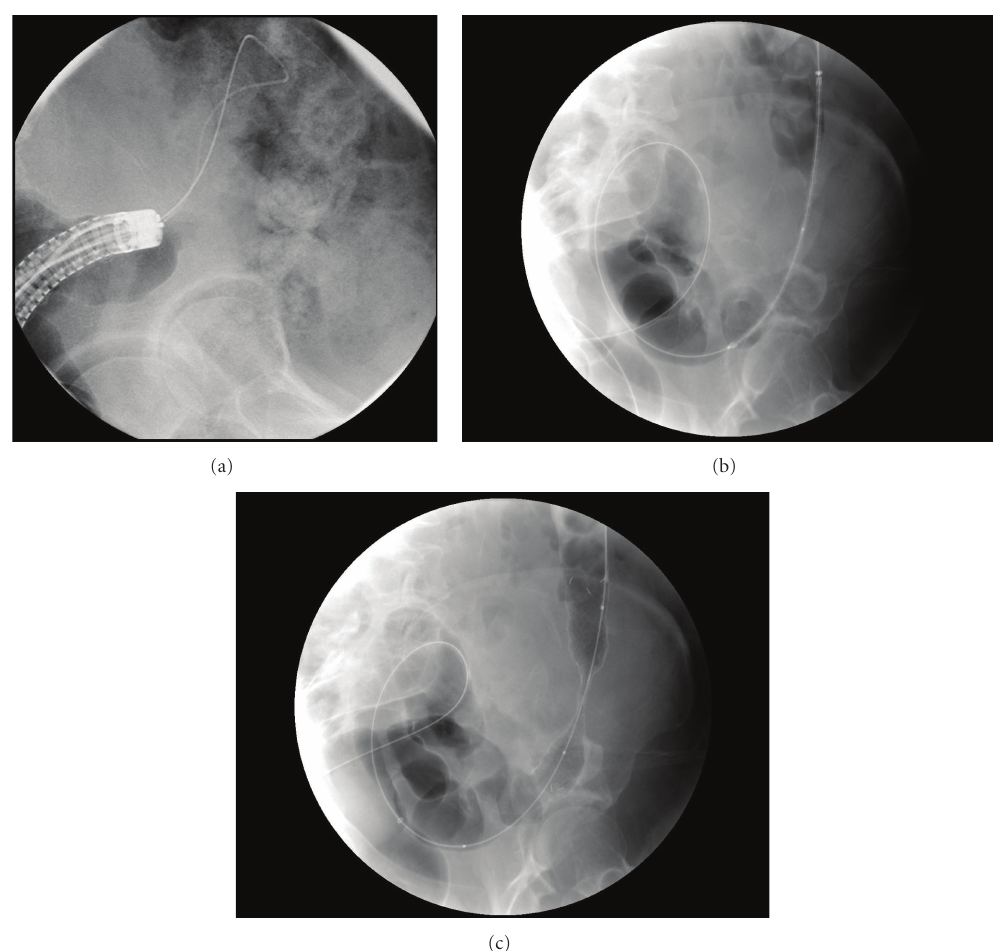
Figure 1: A series of images demonstrating the stages involved in endoscopically guided colorectal stenting. (a) The tumour is directly visualised with the endoscope, and the guide wire is passed through the end of the scope. (b) The deployment system is passed through the stricture. (c) The stent has been successfully deployed. The stent boundaries can be clearly